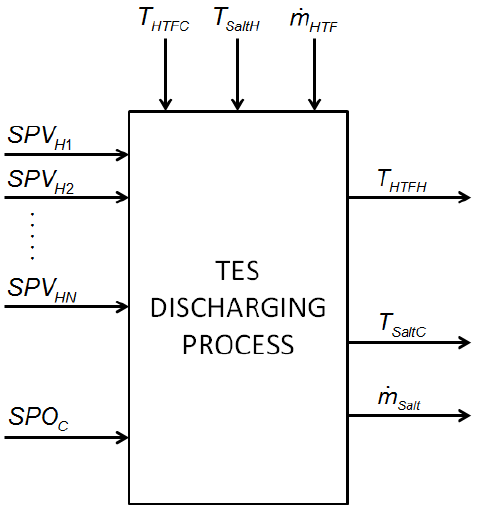
Figure 5. Process block associated to TES